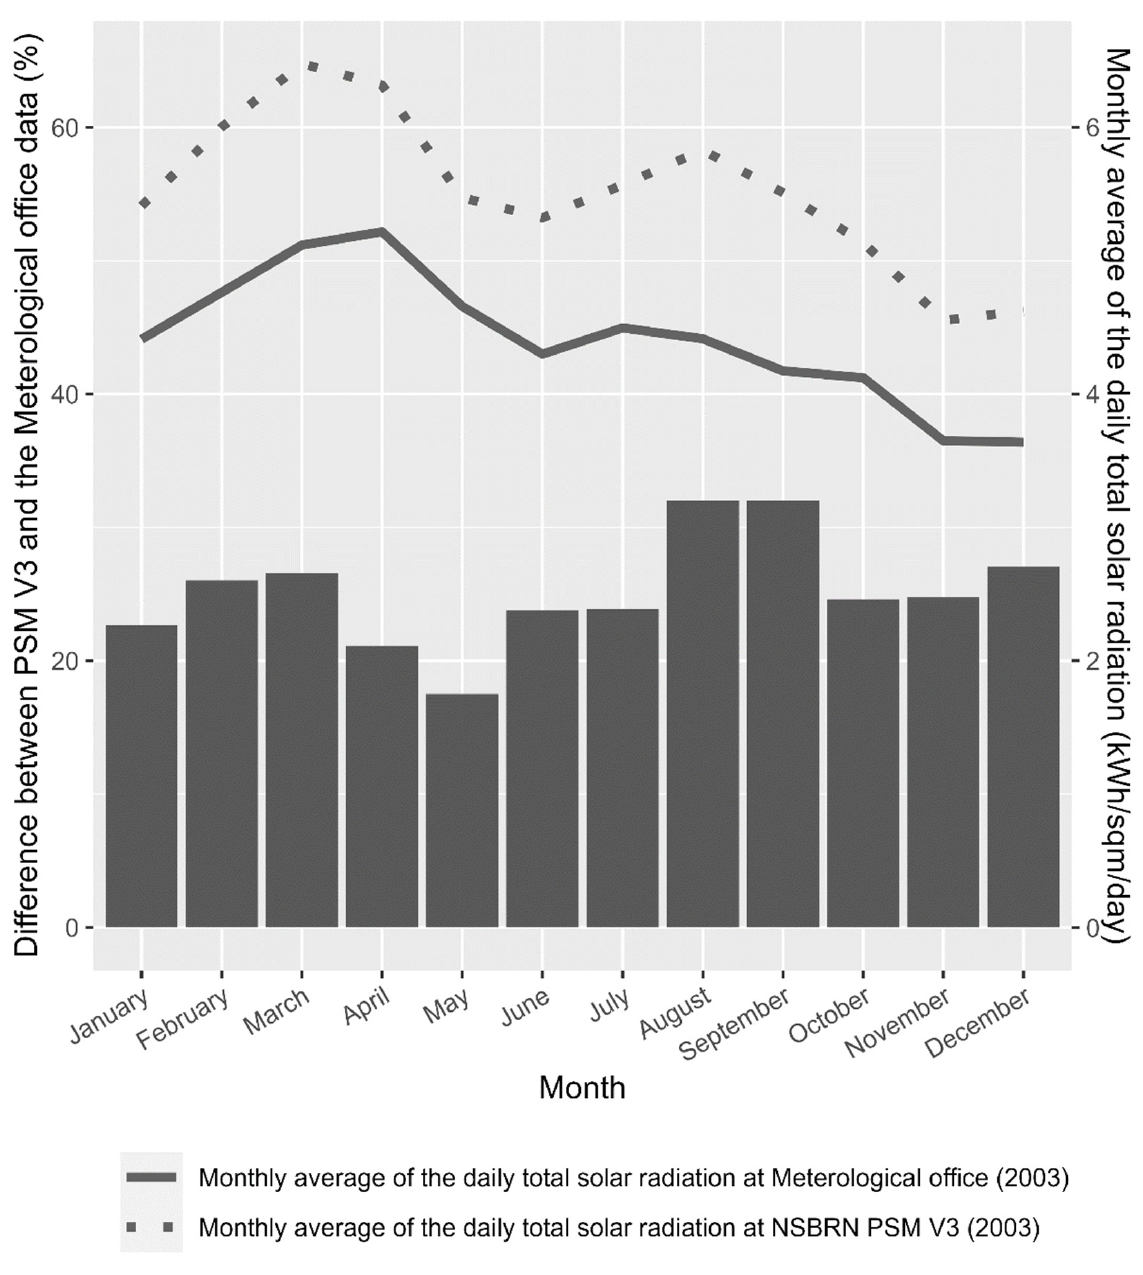
Figure 7. Data comparison between NSRBN’s PSM V3 2003 and the ground-measured data obtained from the Trinidad and Tobago Meteorological Service in 2003.